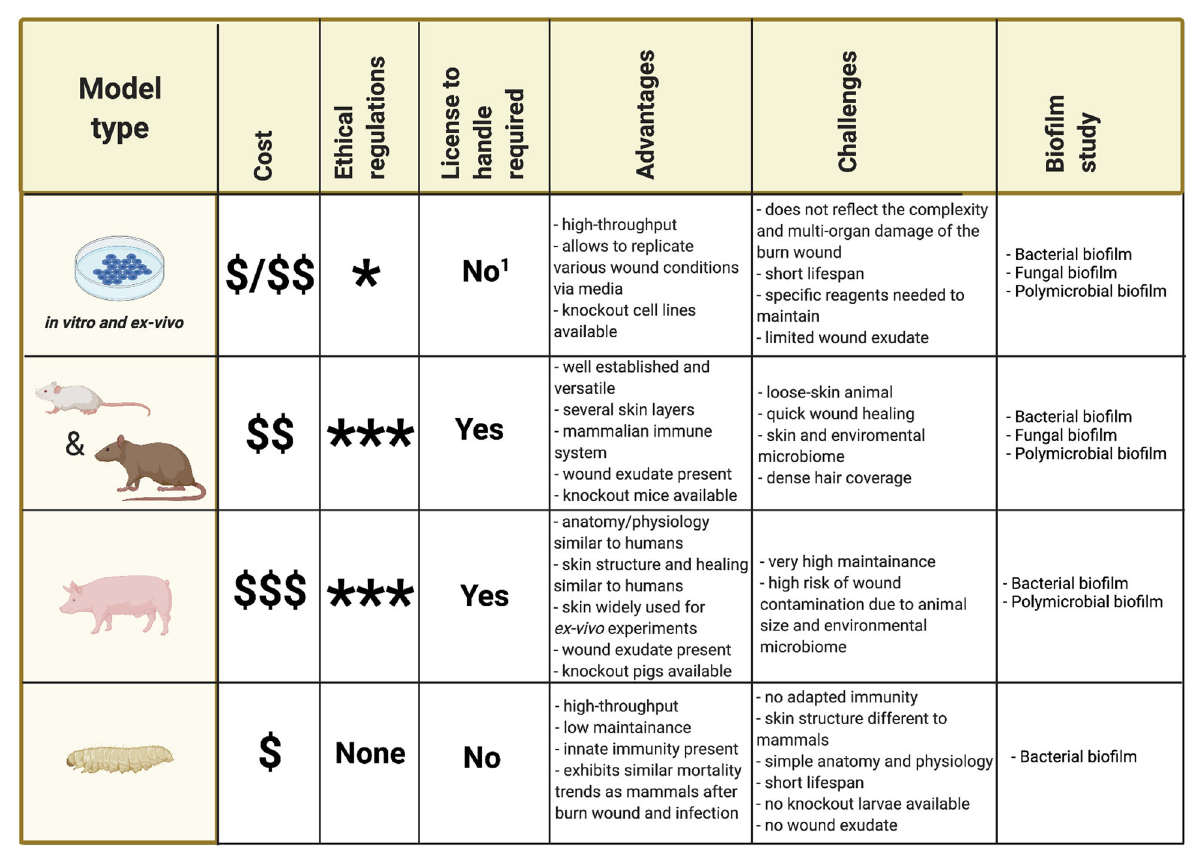
Fig. 3 A comparative table of the burn wound and infection models. 1 Licensing is required on a case-by-case basis for human explants. Created with